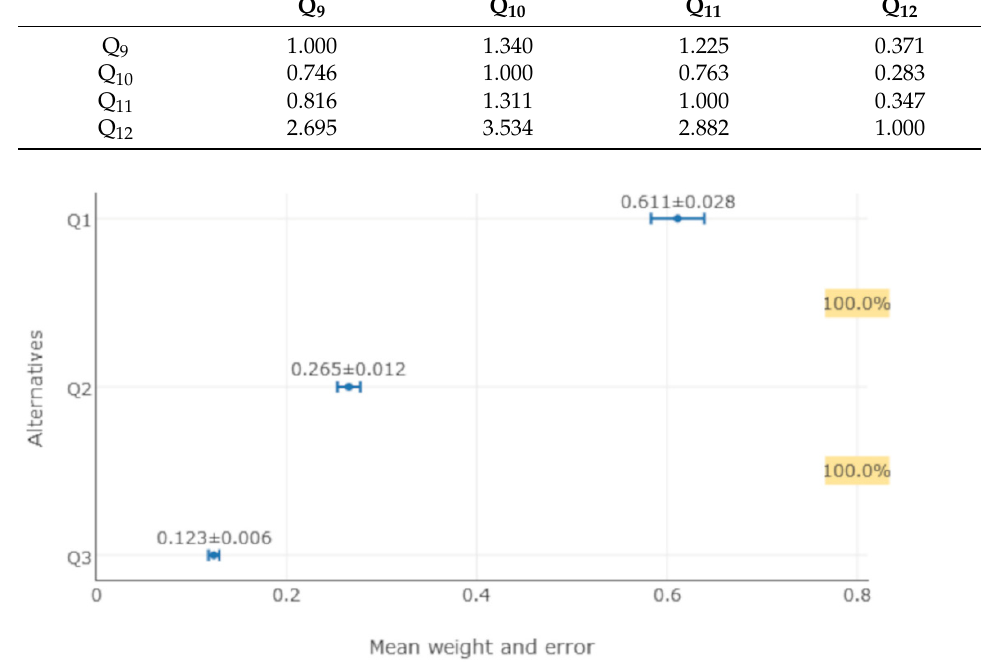
Figure 2. Alternatives (questions’ importance) comparison results with their mean weights, absolute errors, and ranking probabilities of compared alternatives Q1–Q3.